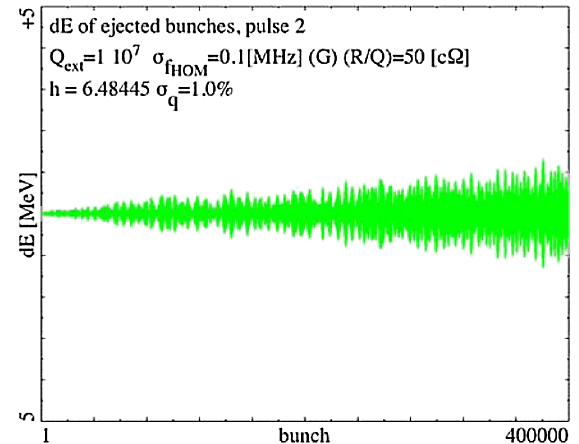
FIG. 75. (Color) dE at ejection [ (cid:3) 5 MeV ], pulse 2, corre- sponding phase space in Fig. 11 (equivalent Fig. 60 but Q ext ¼ 10 7 ). The displayed 2nd pulse starts at zero amplitude here since no significant fields survives the beam-pulse pause at Q ext ¼ 10 7 .